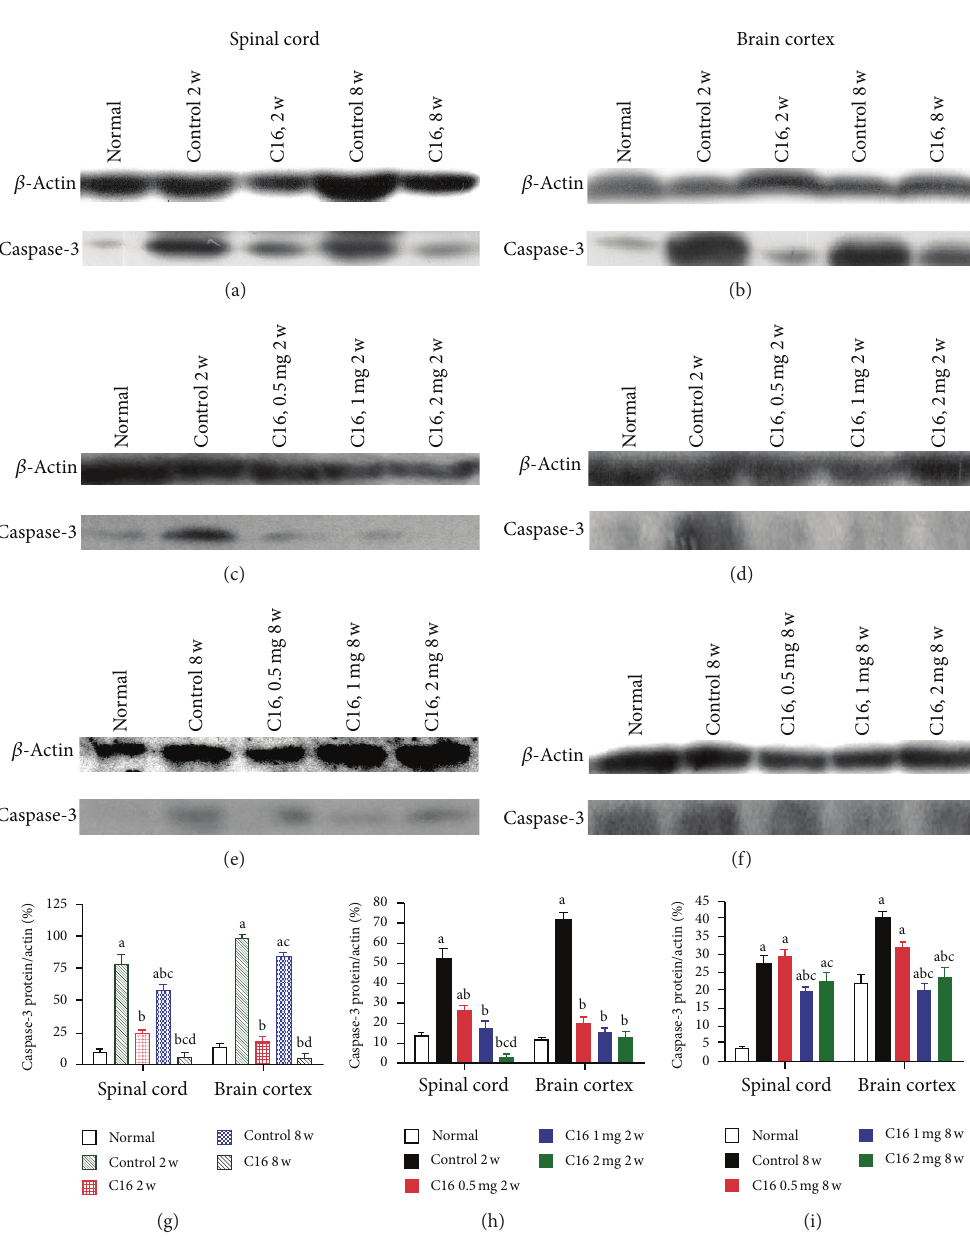
Figure 11: The expression levels of caspase-3 were declined remarkably both in spinal cord (a) and cerebral cortex (b) by late C16 application compared with the vehicle control, evaluated by Western blotting analysis. The levels of caspase-3 expression were evidently decreased both in spinal cord (c) and cerebral cortex (d) by medium to high-dose C16 treatment at week 2 post-immunization. Caspase-3 expression levels were evidently decreased both in spinal cord (e) and cerebral cortex (f) by medium to high-dose C16 treatment at week 8 after immunization. (g) The levels of caspase-3 expression were suppressed by late treated C16 treatment to a certain extent, revealed by Western blotting analysis: a 𝑃 < 0.05 versus normal rats, b 𝑃 < 0.05 versus vehicle control rats, c 𝑃 < 0.05 versus C16 treated EAE rats at week 2 postimmunization group; d 𝑃 < 0.05 versus vehicle control rats at week 8 after immunization. (h) The levels of caspase-3 expression were reduced by medium to high-dose C16 treatment at week 2 after immunization (i) The levels of caspase-3 expression were reduced by medium to high-dose C16 treatment at week 8 after immunization: a 𝑃 < 0.05 versus normal rats and b 𝑃 < 0.05 versus vehicle control rats; c 𝑃 < 0.05 versus 0.5 mg/per day C16 treated EAE rats, d 𝑃 < 0.05 versus 1mg/per day C16 treated EAE